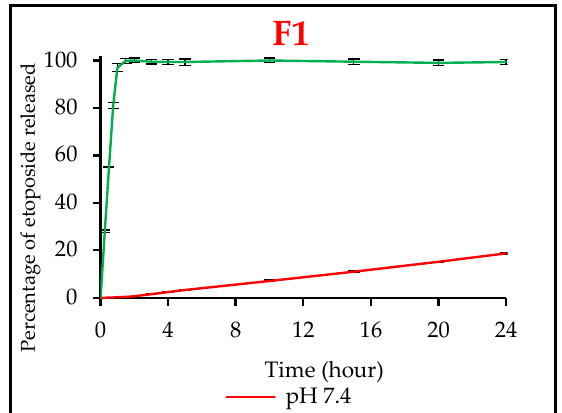
Figure 25. Dissolution profile of etoposide from formula F1 in phosphate (pH 7.4) and acetate (pH 4.6) buffer solutions at 37 ± 1 °C (data are represented as mean% ± SD for